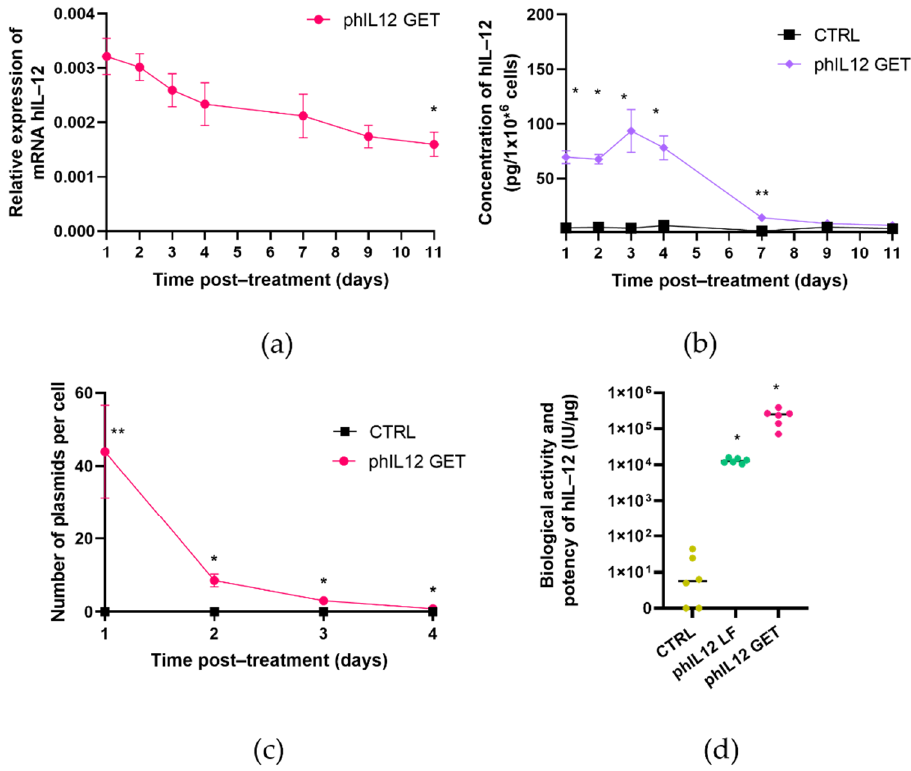
Figure 5. GET of phIL12 in the FaDu cell line. ( a ) Relative expression of hIL-12 mRNA in the target cells; * p < 0.05—statistically significant difference compared to day 1. ( b ) Expression of hIL-12 on the protein level; * p < 0.05—statistically significant difference compared to the expression levels at days 7, 9 and 11 and the control group; ** p < 0.005—statistically significant difference compared to the expression levels at days 1, 2, 3 and 4 and the control group. ( c ) Copy number of plasmid DNA per cell; ** p < 0.005—statistically significant difference compared to the copy number at days 2, 3 and 4 and the control group; * p < 0.05—statistically significant difference compared to the copy number at day 1 and the control group. ( d ) Biological activity and potency of the hIL-12 protein in control untreated cells (dark yellow), in phIL12 Lipofectamine (LF) transfected cells (green) and in phIL12 gene electrotransfer (GET) transfected cells (pink); * p < 0.05—statistically significant difference compared to the control cells. All the experiments were repeated three times, each of them including two separate biological replications.